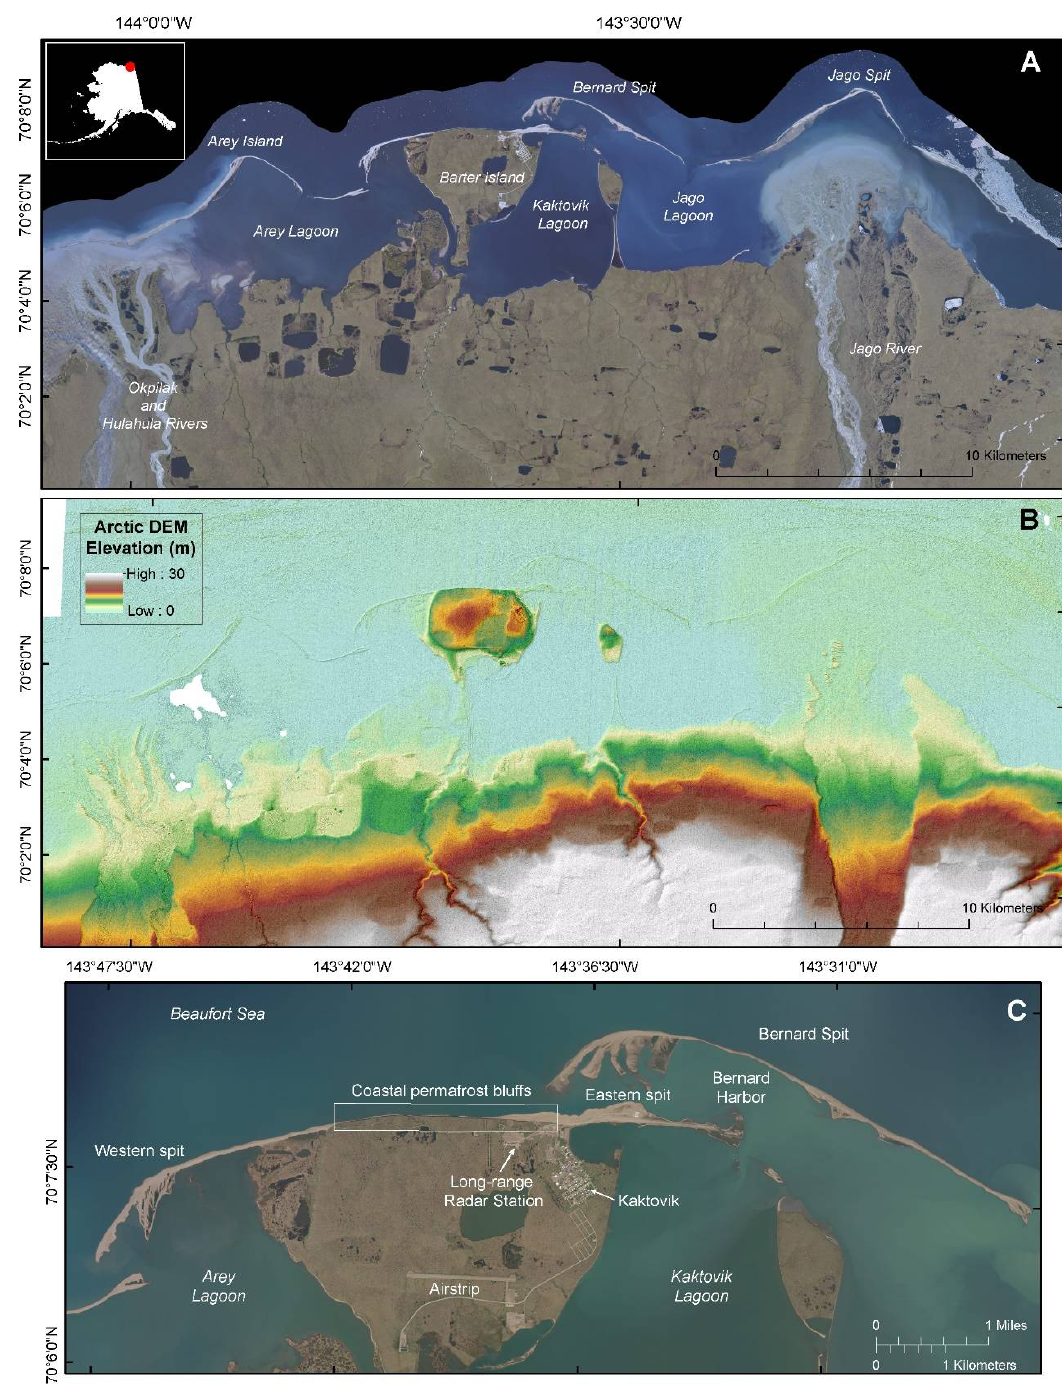
Figure 1. ( A ) Regional location of the area near Barter Island, Alaska, showing locations discussed in the text. Imagery base is 2013 SPOT5 RGB (https://gis.data.alaska.gov/pages/Imagery%20Program; accessed on 1 October 2021). ( B ) Elevation map of the region from the Arctic DEM (https://www.pgc.umn.edu/data/arcticdem/ accessed on 3 March 2021). Note the anomalously high elevation of Barter Island compared to the surrounding coastal features. ( C ) Detailed location map of Barter Island and Bernard Spit. The white box outlines the 3.2 km section of coastal bluffs. Imagery base is Alaska High Resolution Imagery RGB (https://gis.data.alaska.gov/pages/Imagery%20Program; accessed on 1 October 2021). Barter Island is a remnant tundra island that sits between two large deltas of the Jago and Okpilak-Hulahula Rivers. It is one of the largest islands along Alaska’s coast, with a total area of nearly 1600 hectares (six square miles). The geological history of the island is